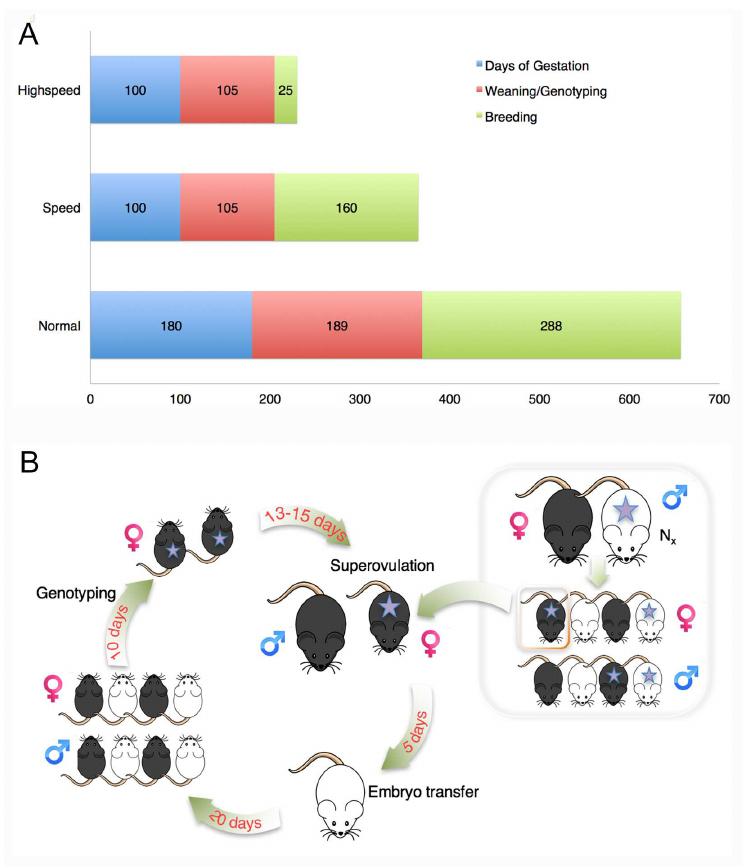
Fig 1. High-speed backcrossing through the femalegermline. (A) Approximate durationof approaches to obtaincongenicstrains, basedon 5 generationsfor marker-assistedstrategies(high-speed, speed)and 9 generations for traditional backcrossing (normal).Assumeddurations:gestation, 20 days; weaning/genotyping, 21 days; breeding,32 days for speedand normal(assumingmaturity of malesat 7.5 weeks),and 5 daysfor high-speed (superovulation at pre-pubertal age). (B) Diagramillustratingthe experimental approach for high- speedbackcrossing throughthe femalegermline. Star, mutationof